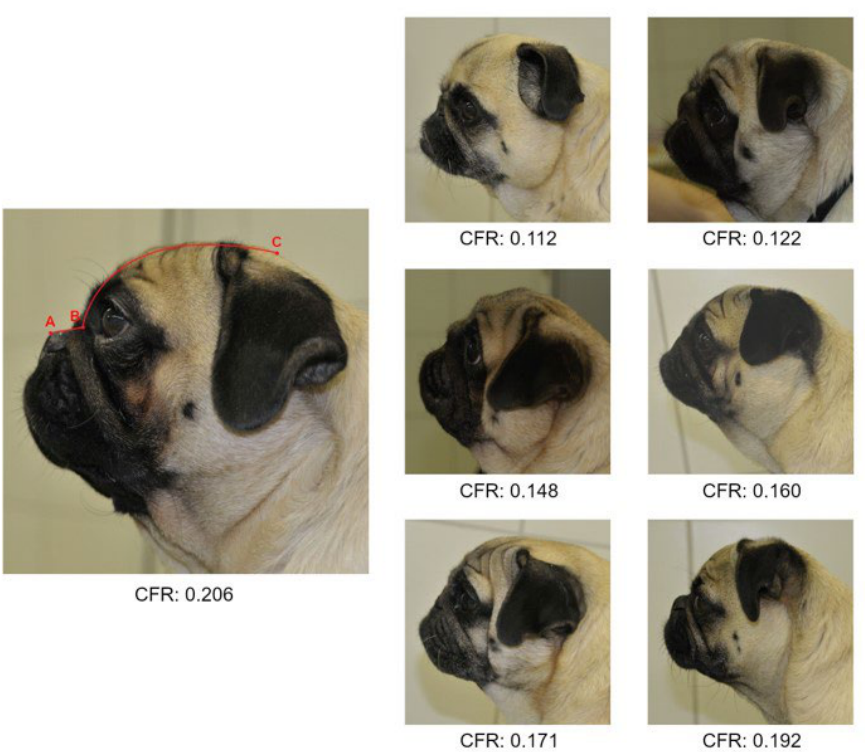
Figure 4. Examples of craniofacial ratios (CFR: ratio of muzzle length (A to B) to skull length (B to C)) measured in this study.